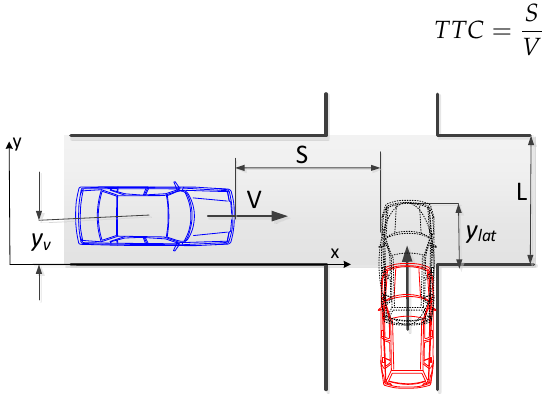
Figure 1. Scheme of a road situation .